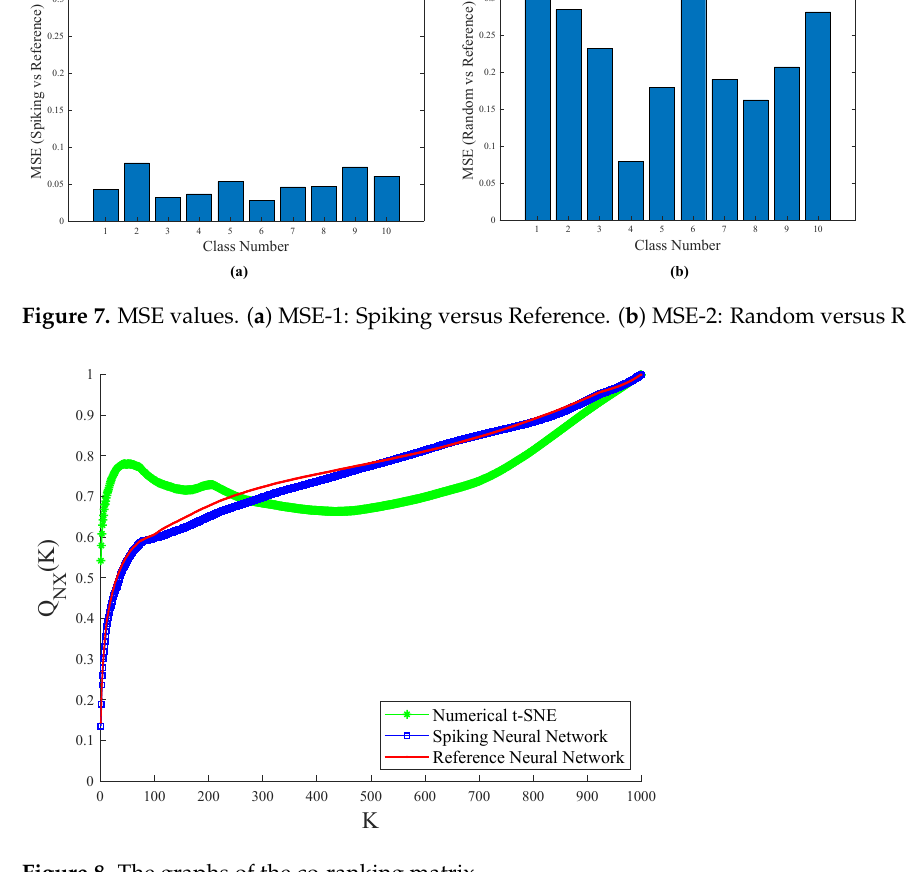
Figure 8. The graphs of the co-ranking